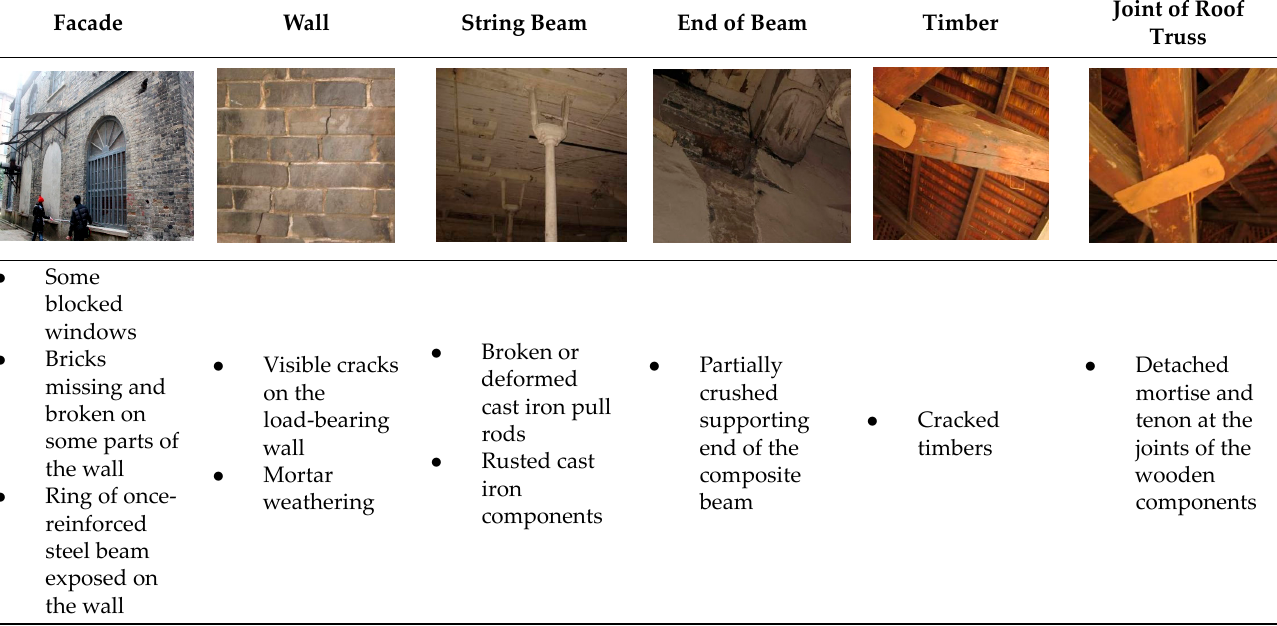
Table 1. Security damage by observation.